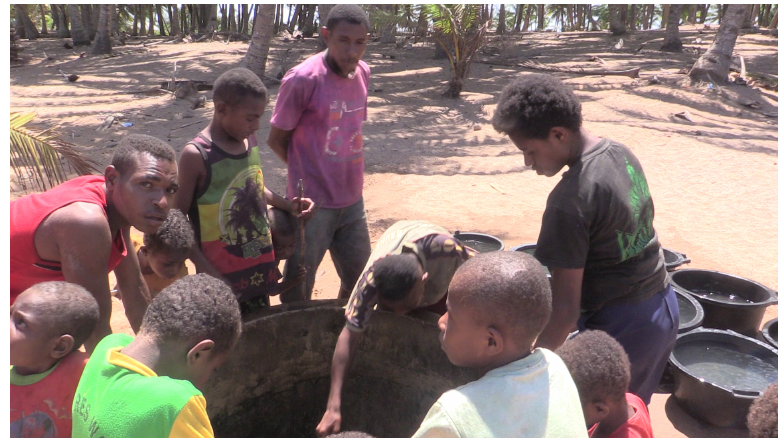
Figure 5: ‘The children are also looking for a rope for you.’; cf. example